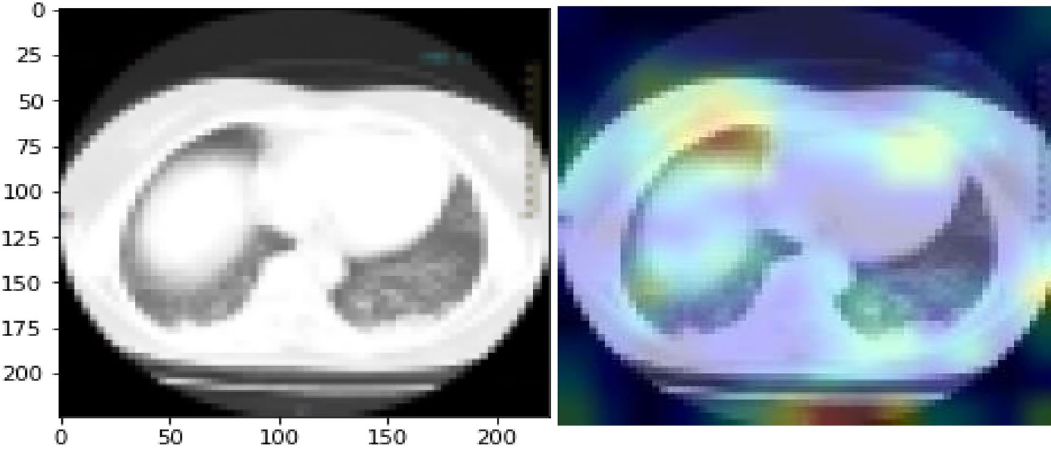
Figure 4. Grad-CAM of proposed model—Heatmap for Non- Covid class.